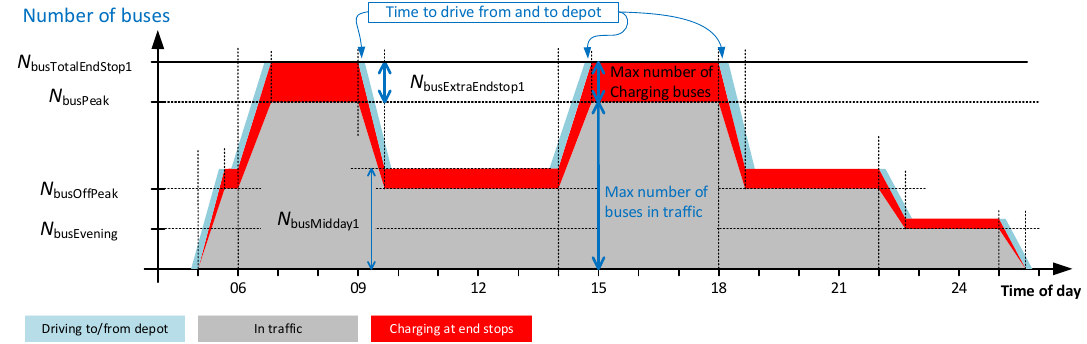
Figure 7. Number of buses, including buses charging at end stops and driving to and from the depot. Energies 2020 , 13 , x FOR PEER REVIEW